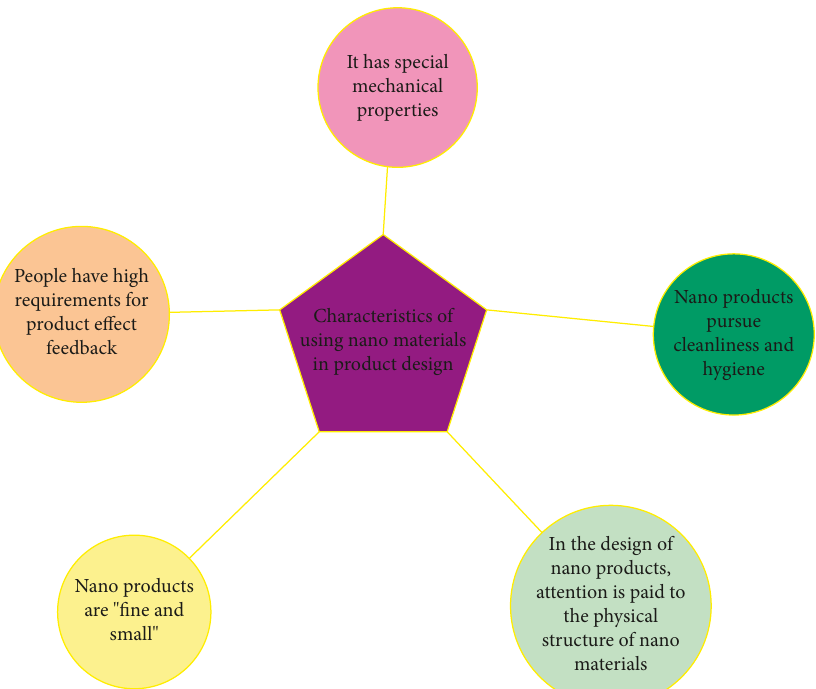
Figure 2: Characteristics of nanomaterials used in product